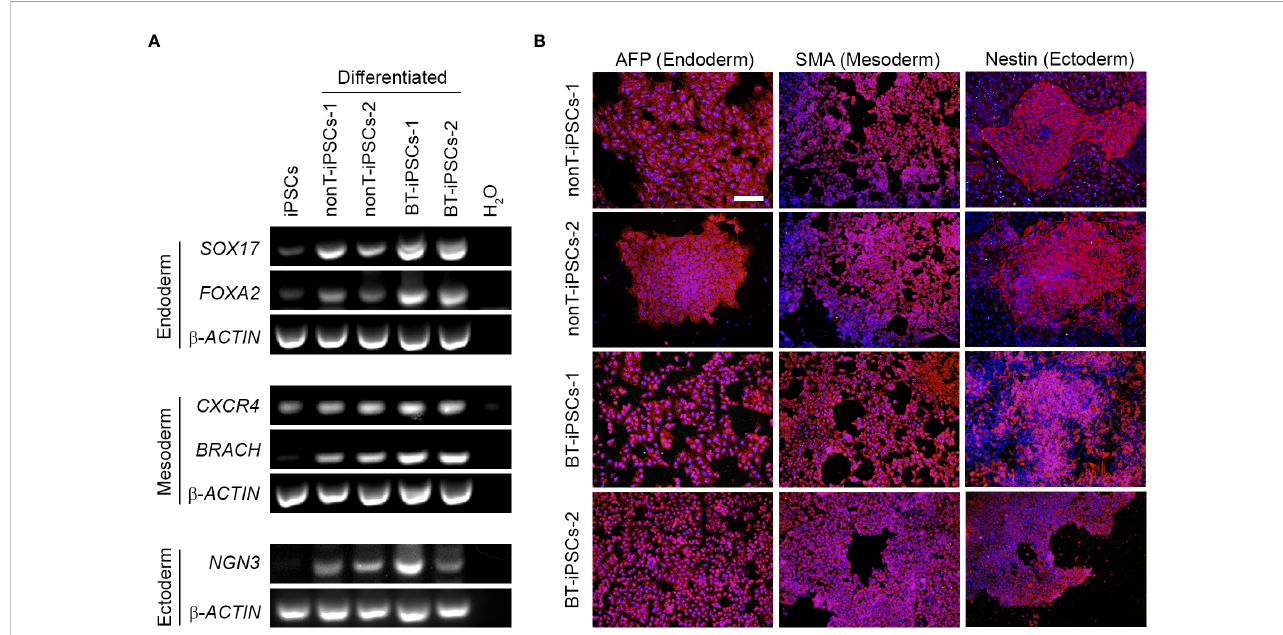
FIGURE 4 Analysis of the differentiation capacity of the generated iPSCs into the three embryonic layers. (A) RT-PCR analysis showing the expression of speci fi c differentiation markers, including markers for endoderm ( SOX17 and FOXA2 ), mesoderm ( CXCR4 and BRACH ) and ectoderm ( NGN3 ). Note that differentiated iPSCs highly express all the trilineage differentiation markers, while undifferentiated iPSCs do not. (B) Immuno fl uorescence staining showing the presence of alfa-fetoprotein (AFP) for endoderm, Smooth Muscle Actin (SMA) for mesoderm and Nestin for ectoderm in the differentiated iPSCs. Nuclei were counterstained with Hoechst 33342. Scale bar 50